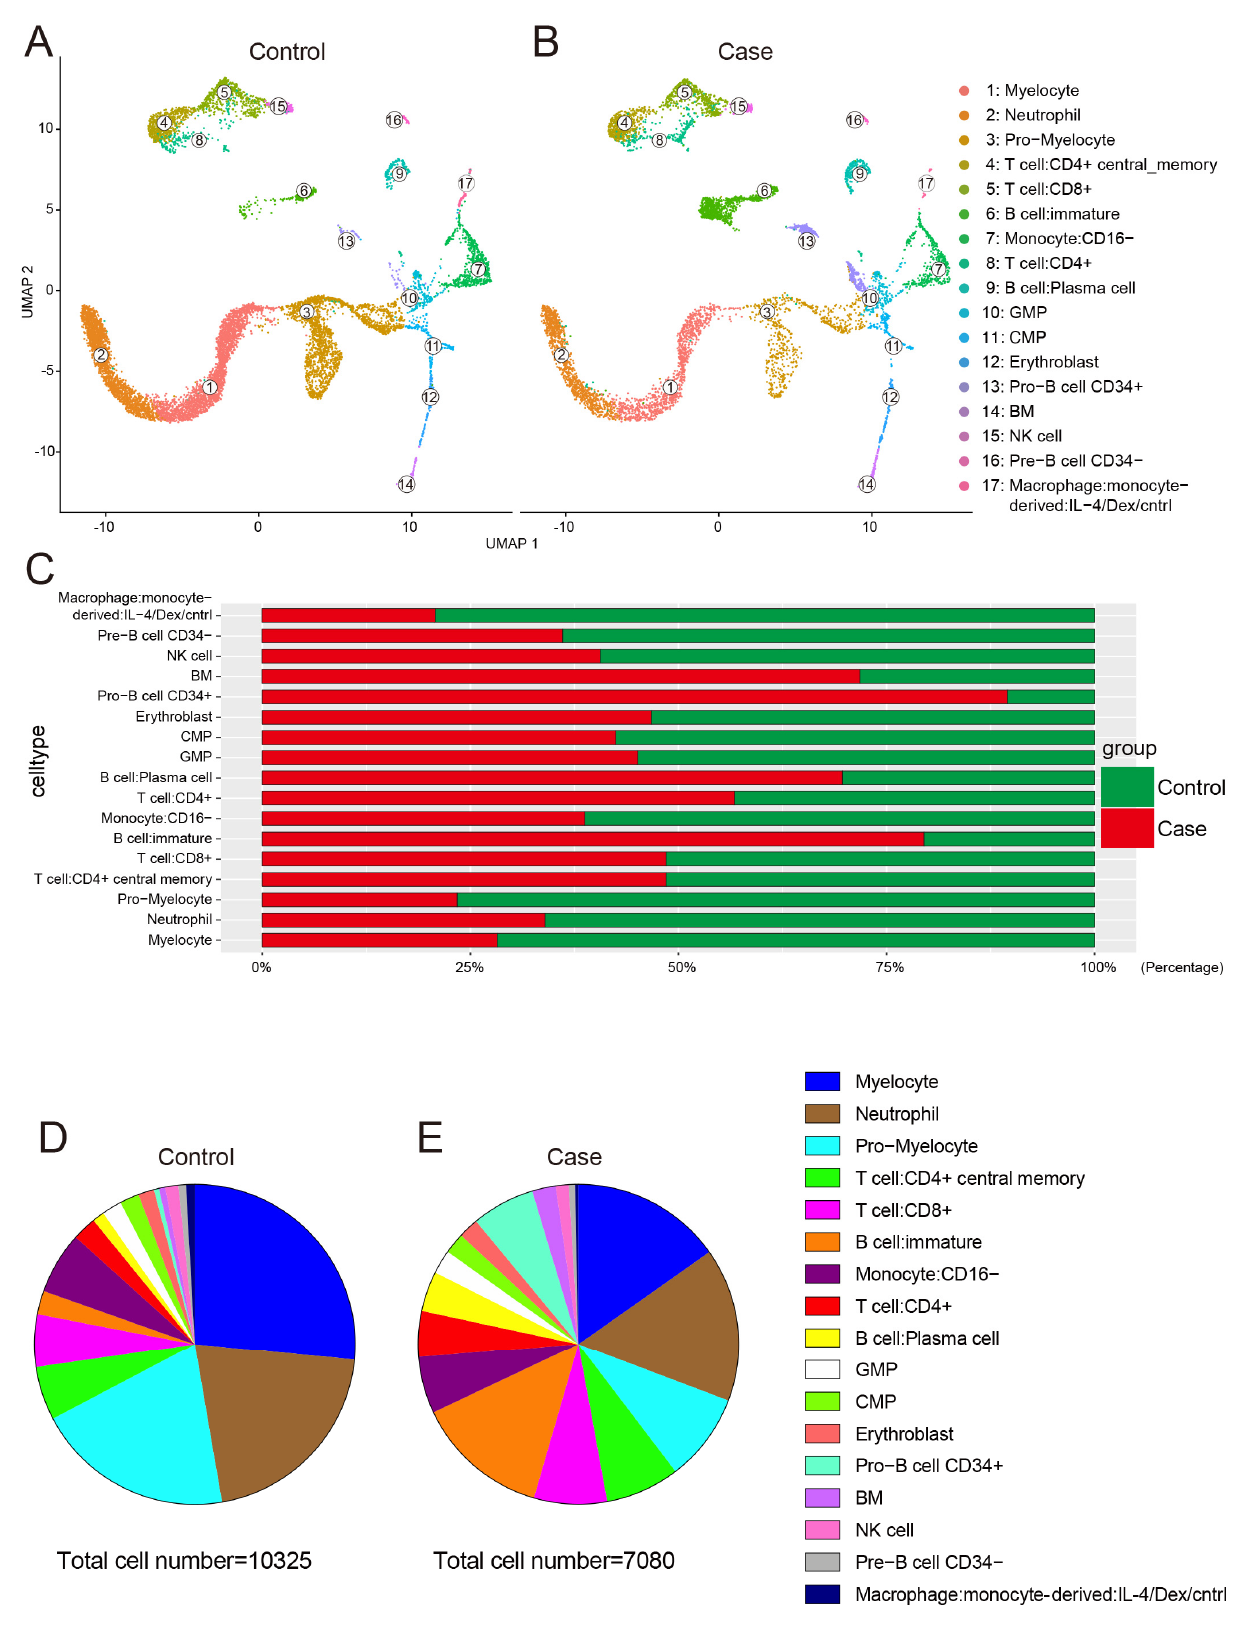
Figure 2. Profile of cell types and corresponding cell number and proportion . The distribution of the same 17 cell types in both the case and control groups ( A , B ). Comparison of the proportion of the same cell type in the case and control groups ( C ). All cell types and corresponding constituent ratio in the control and case groups ( D , E ).